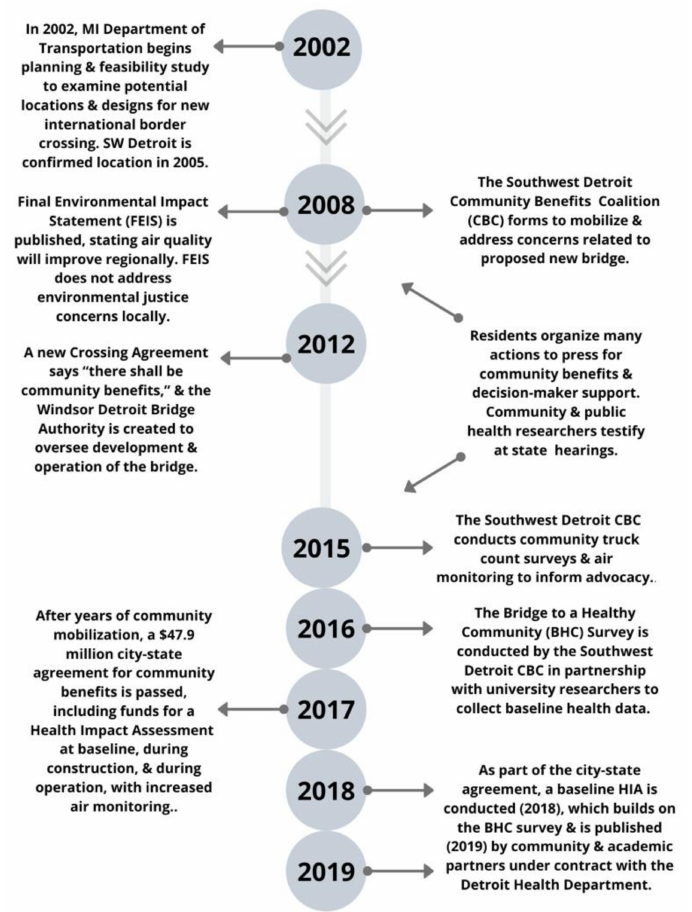
Figure 1. Timeline of key events leading up to the Gordie Howe International Bridge (GHIB) Health Impact Assessments